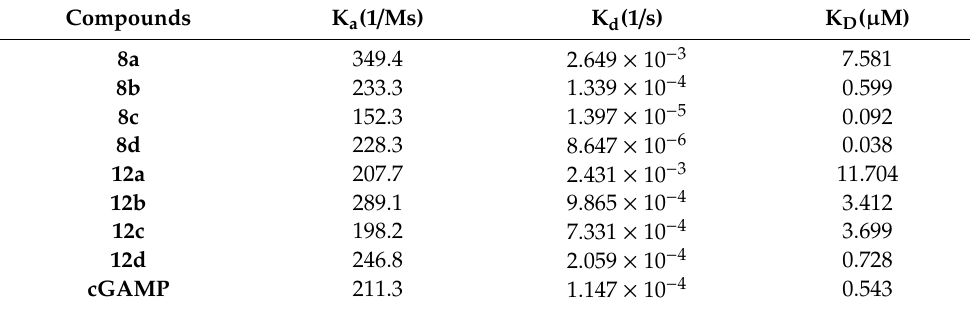
Table 1. Binding a ffi nities of the cyclic GMP-AMP (cGAMP) analogs with human stimulator of interferon genes (STING).